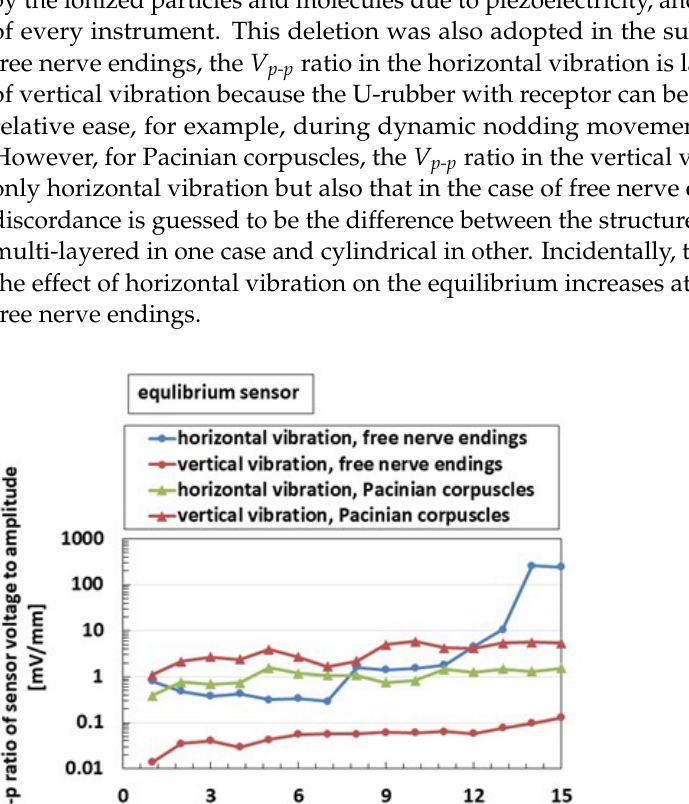
Figure 12. Schematic of physical model of equilibrium performance by inclination of equilibrium sensor mimicking a saccule.